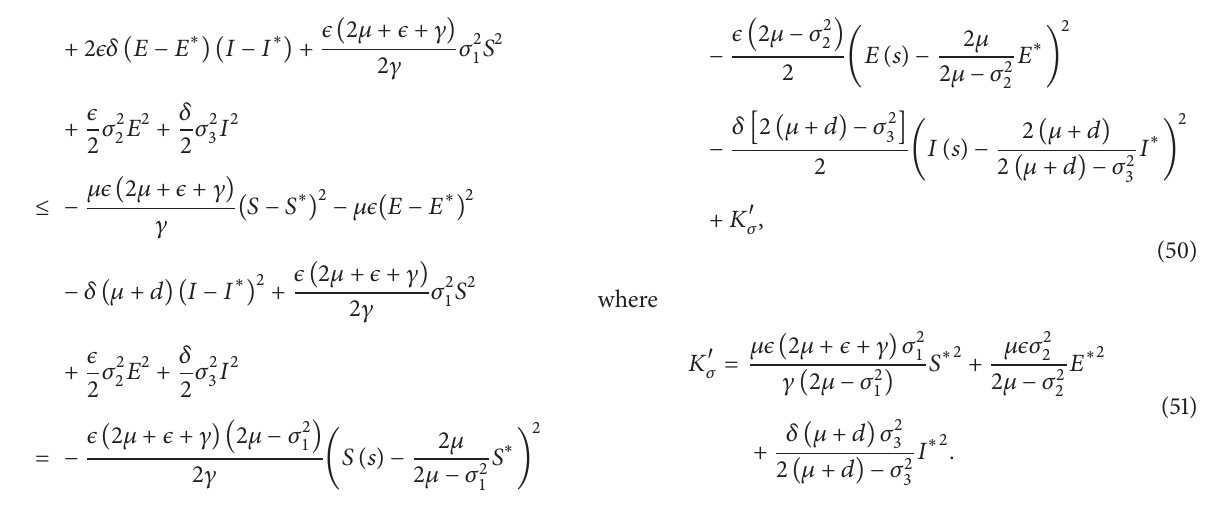
= 0.01 , 𝜎 = 0.02 , and 𝜎 = 0.01 1 2 3